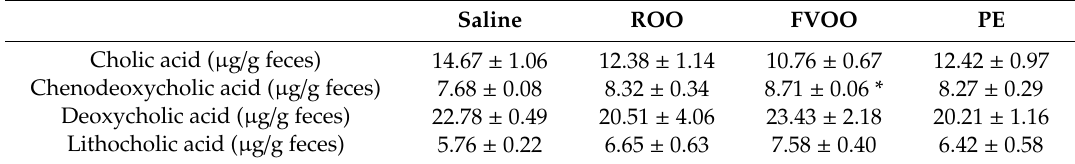
Table 2. Fecal bile acids in C57BL / 6 mice administered saline, ROO, FVOO, or PE for 14 days. Saline ROO FVOO PE Cholic acid ( µ g / g feces)